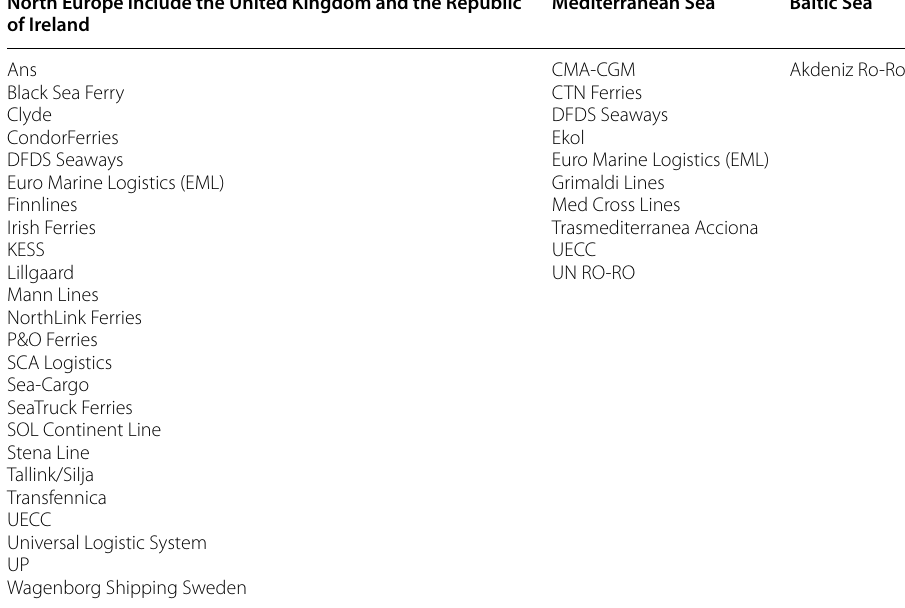
Table 4 RoRo Ferry companies across the United Kingdom, Republic of Ireland, Northern Europe, Mediterranean and Baltic